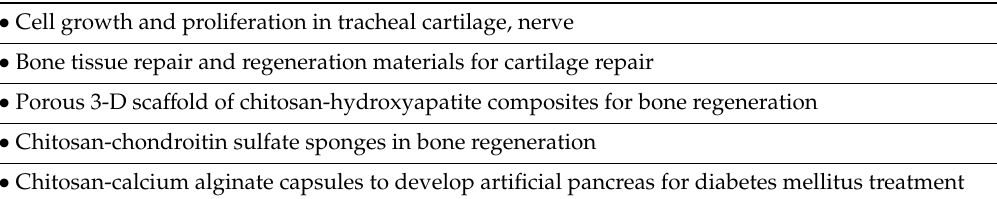
Table 5. Some applications of chitosan in tissue